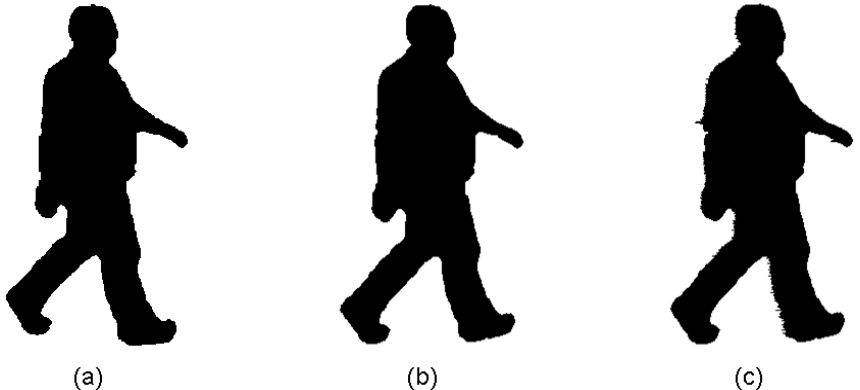
FIGURE 5 . (a) Originally extracted silhouette, (b) rotated silhouette, (c) rotated silhouette with added emerging